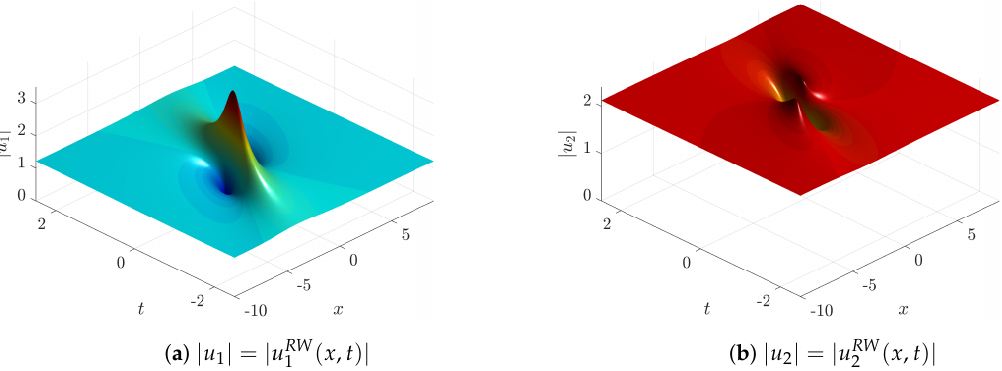
( x , t ) | / a = 1.5518, max | u RW ( x , t ) | / a = 2.962. 2 1 2 1